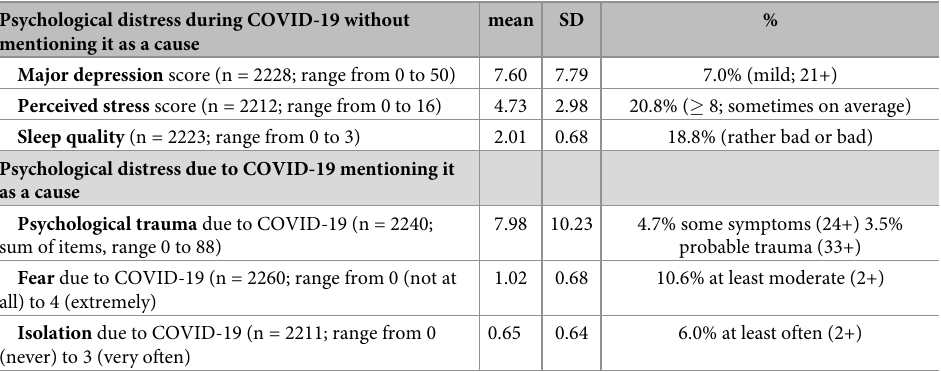
mean SD % 7.98 10.23 4.7% some symptoms (24+) 3.5% probable trauma (33+) 1.02 0.68 10.6% at least moderate (2+) 0.65 0.64 6.0% at least often